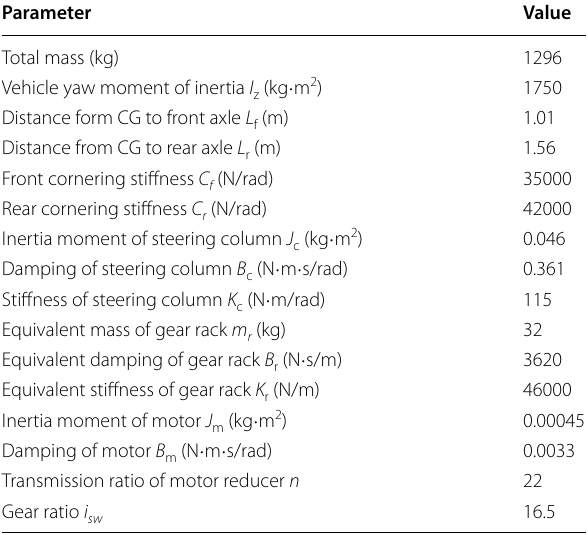
Table 4 Parameters of vehicle and EPS